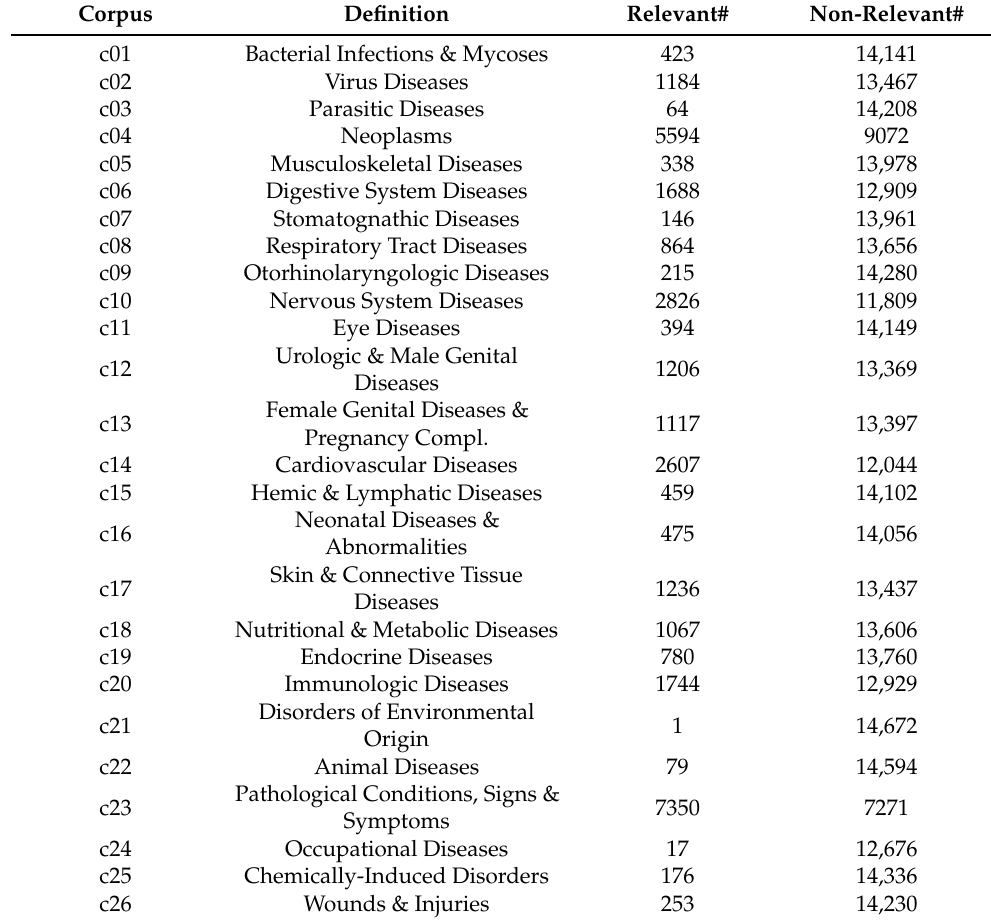
Table 1. Number of relevant and non-relevant documents of the OHSUMED version used in the study. Corpus Definition